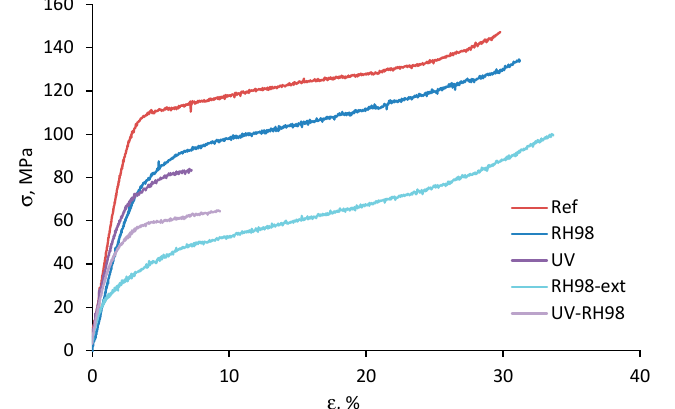
Figure 5. Representative stress-strain diagrams of wool fibers exposed to different environments; LE = 30 mm.